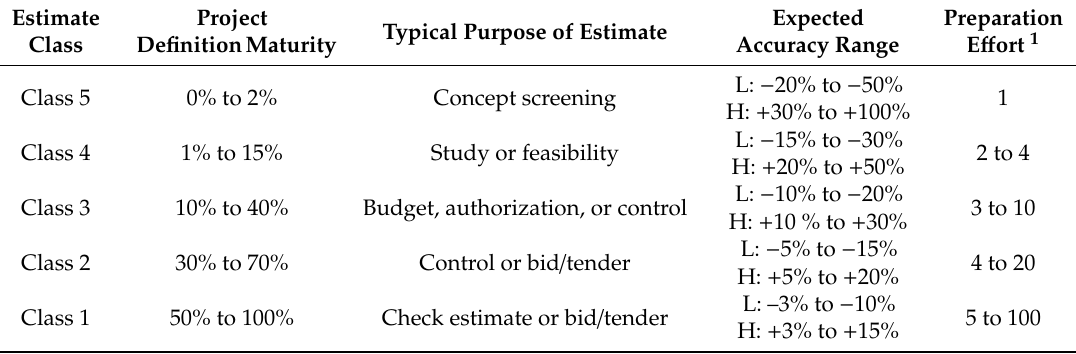
Table 2. Mission of the economic analysis